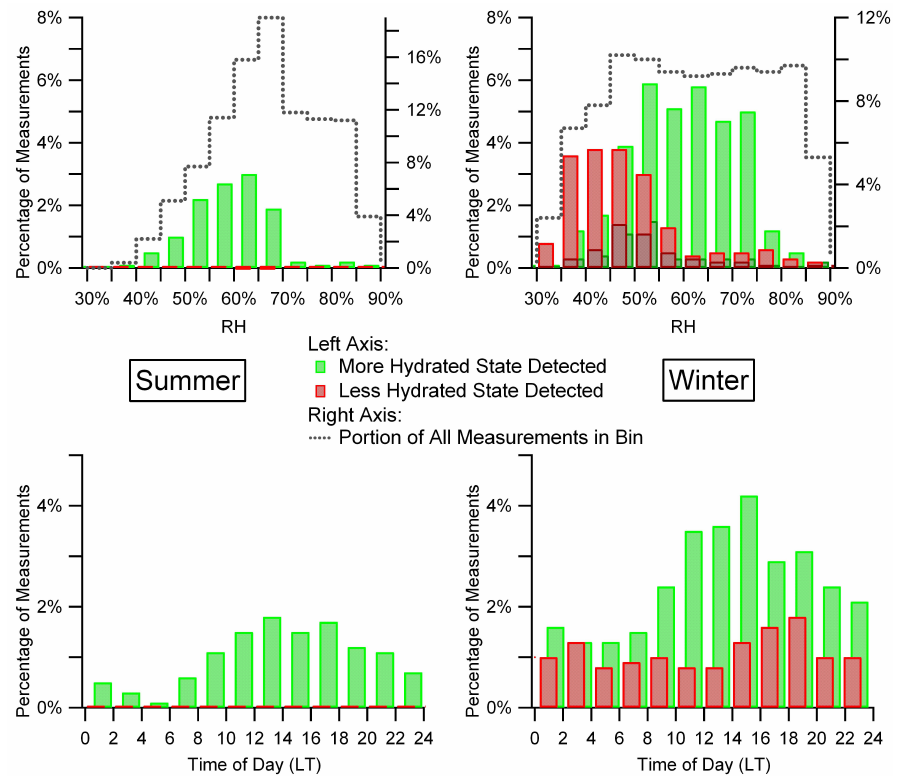
Fig. 12. Frequency plots of hysteresis detection versus RH and time-of-day for summer and winter campaigns. The darker portion of the bars in the winter RH plot indicates fractions detected in coincidence with the alternative hydration